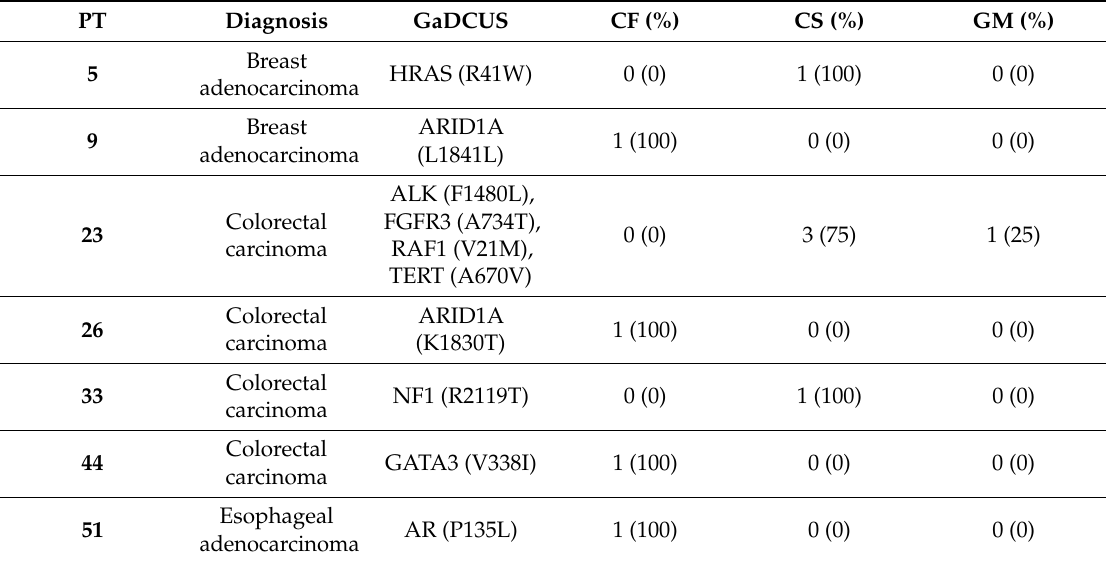
Table 2. Nineteen patients with Guardant360 alterations detected in Caris unclassified section (GaDCUS) and 26 discovered somatic alterations that are potentially treatable. Identified gene mutations show the amino acid alteration in parentheses. Alterations are stratified into the three core cellular process categories to seek trends. Parentheses within the stratified columns represent percentages. See appendix for